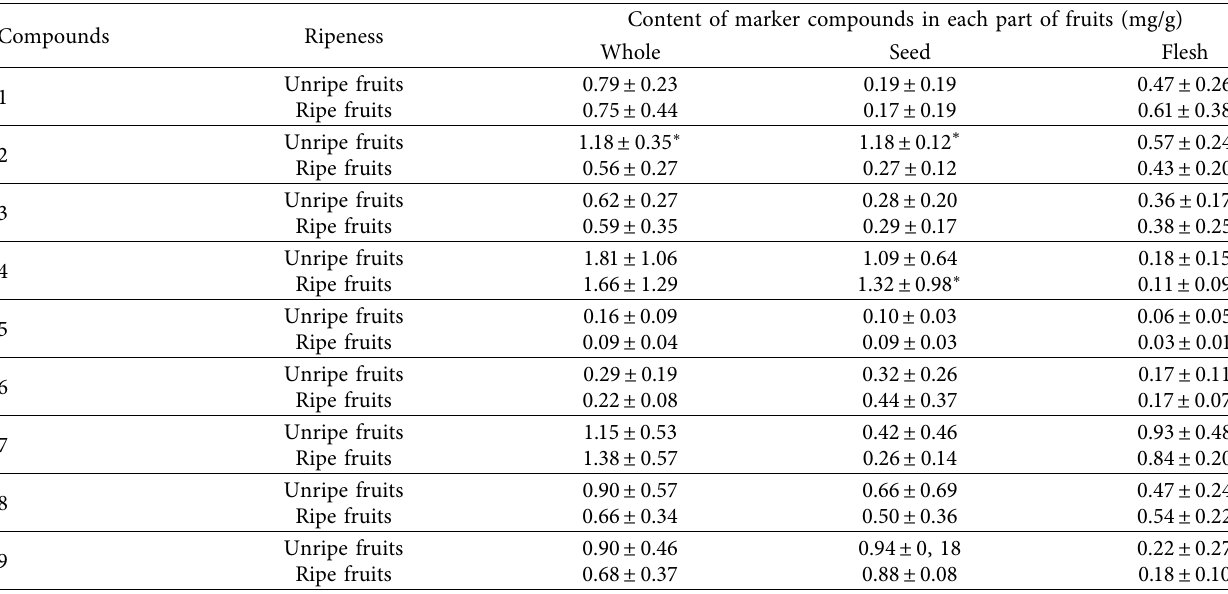
All data were repeated with the triplet, nonpair t -test, significant at ∗ p < 0 .